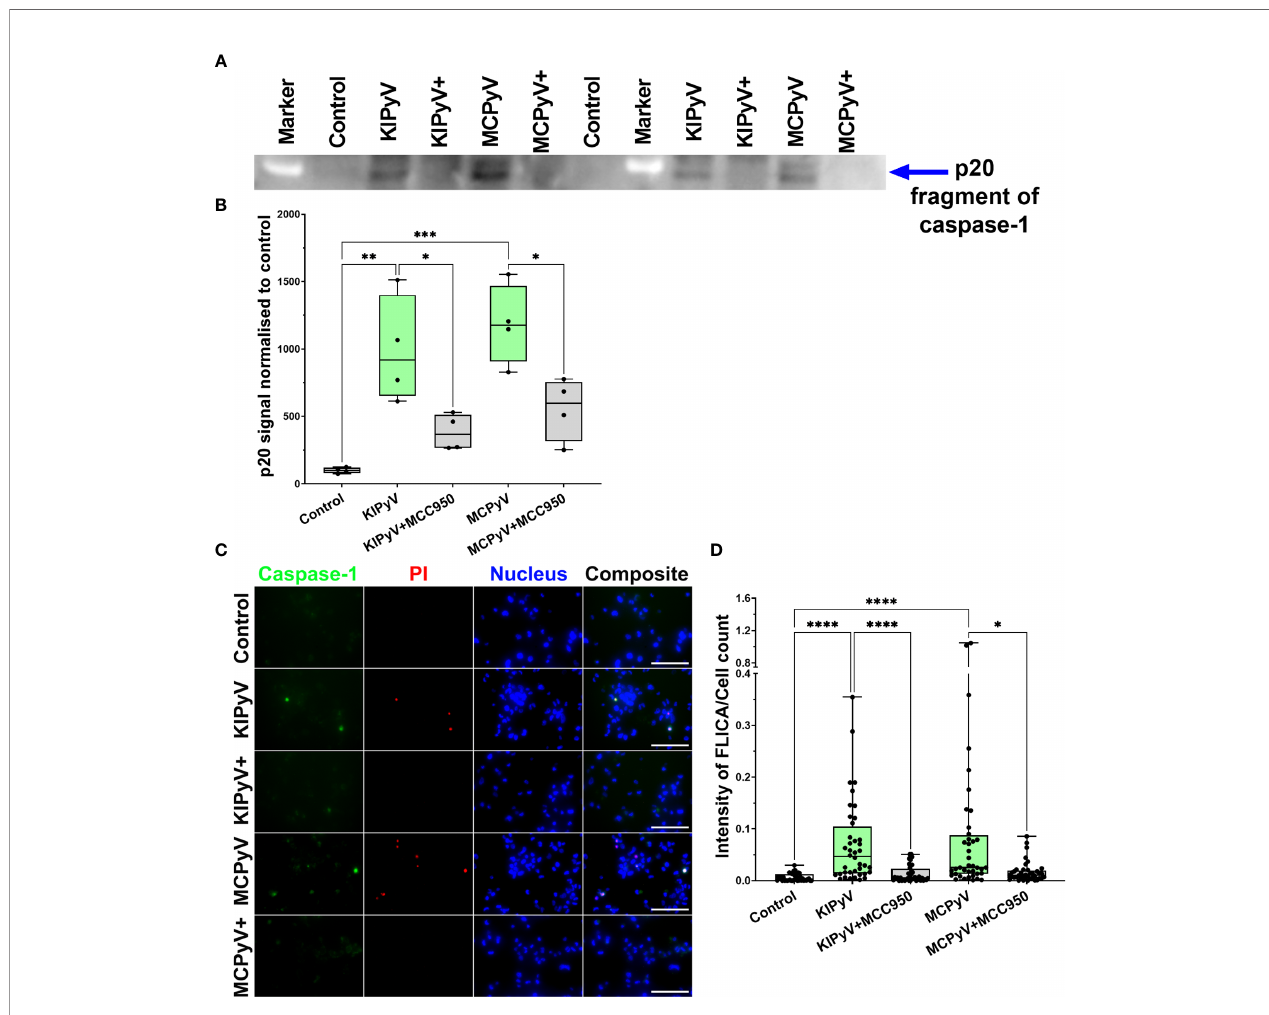
FIGURE 4 | PyV-derived VLPs induced caspase-1 activation in human THP-1 macrophages. Macrophages were treated for 15 h with PyV-derived VLPs (20 µg/ml); inhibitor MCC950 (1 m M) was added 30 min before treatment. (A) Cleaved caspase-1 was determined in cell supernatants by WB. The WB fragment of cleaved caspase-1 (p20 fragment) is shown. See Supplementary Figure 3 for full WB image. “ + ” refers to MCC950 pre-treatment. Duplicates of one experiment are shown. (B) Quanti fi cation of p20 fragment of caspase-1; duplicates of each experiments were quanti fi ed, N =2. (C) Representative images of the activated caspase-1 staining by FLICA (green) reagent. Dead cell nuclear stain PI (red) and nuclear stain Hoechst (blue) was used. The images were taken using 20× objective. The scale bars indicate 100 m m. (D) Caspase-1 quanti fi cation according to FLICA analysis, n = 40 photos per condition. N = 1. Data are represented using box plots showing number of photos and analyzed by Kruskal – Wallis test with Dunn ’ s post hoc , * p < 0.05, ** p < 0.01, *** p < 0.001, **** p <